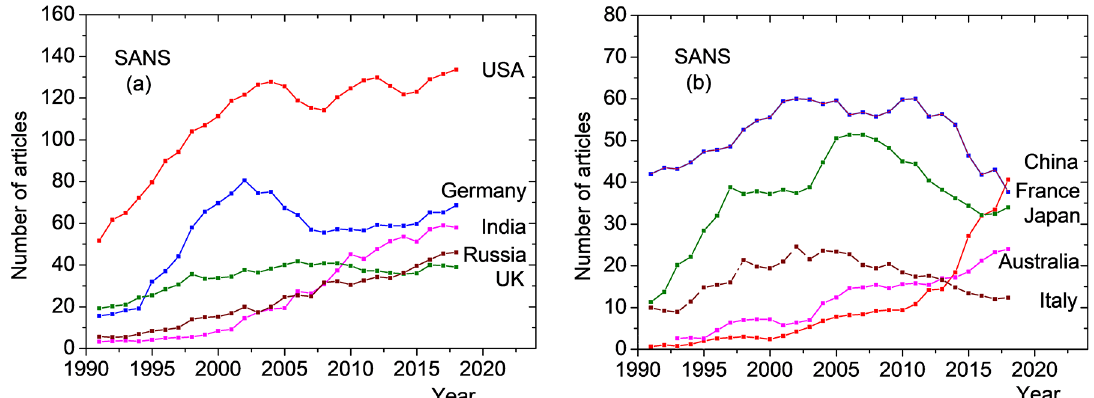
Figure 4. Historical evolution of the annual number of articles related to SANS published by authors from the ten most productive countries in 2018. (a) Countries for which the number of articles published in 2018 range from ~ 50 up to 150. (b) Countries for which the number of articles published in 2018 range from ~ 10 up to 40. Data in (a) and (b) were smoothed by five adjacent points averaging.